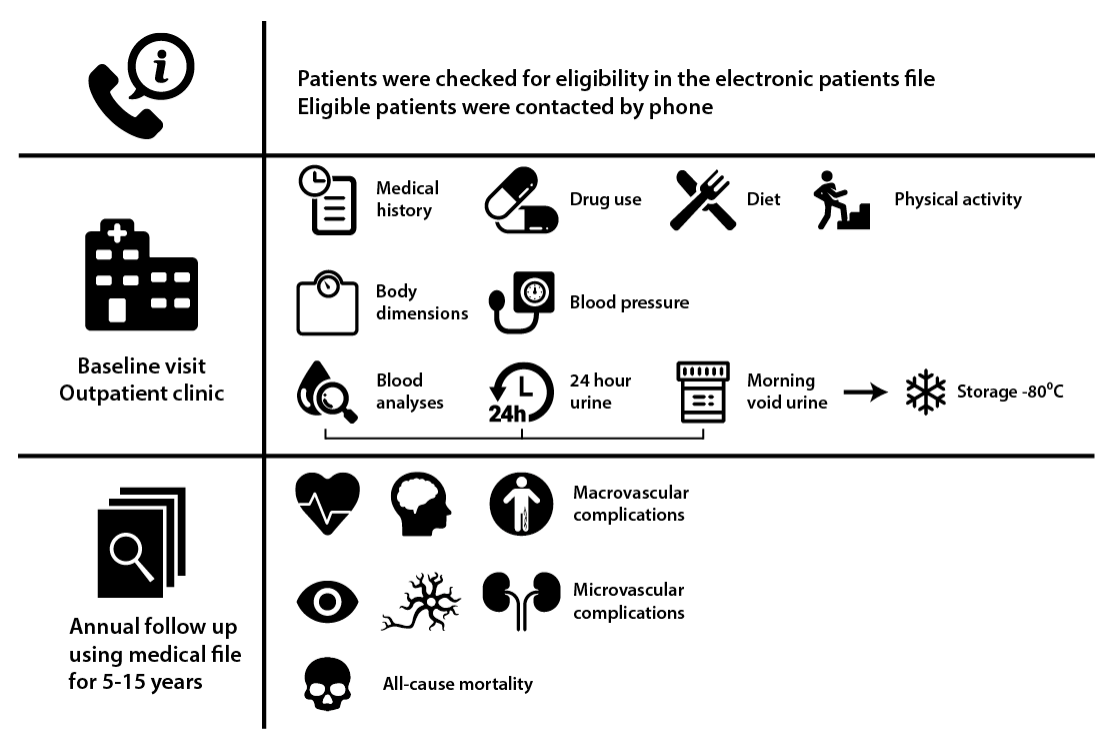
Figure 1. Patient inclusion and data collection.